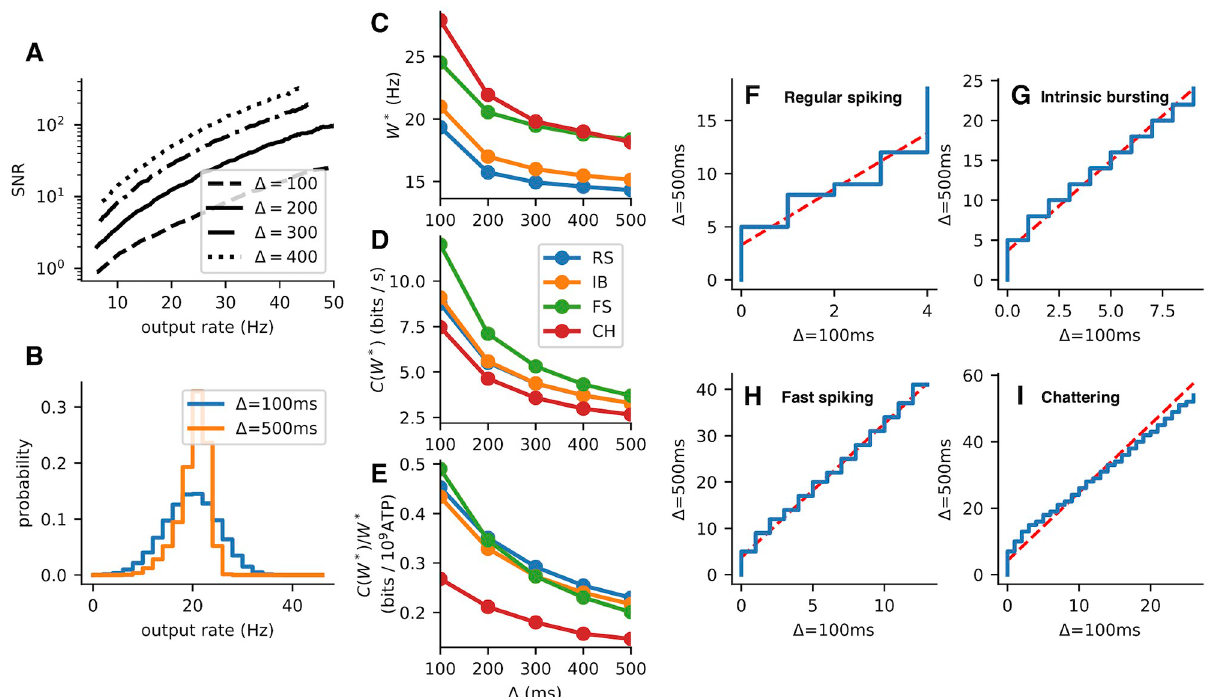
Fig 8. The effect of coding time window on metabolically efficient information transmission. (A) Signal to noise ratio for different coding time windows as a function of the mean response r ( x ) (Eq 26). (B) Comparison of response to a given stimulus (producing a response rate of approx 20 Hz) for different coding time windows. In order to get comparable results, the distribution on number of spikes in 100 was five times convoluted with itself. The distribution for 100 ms is more spread due to the adaptation effects. (C) Optimal mean PSFR (Eq 22). (D) Information capacity with the optimal metabolic expenses. (E) Metabolic efficiency in bits per spikes. The decrease with the length of the coding time window shows us, that the adaptation effects visible in B don’t play a significant role in this case. (F-I): Quantile-quantile plots comparing the PSFR distributions for different coding time windows. The red dashed line is a linear fit, acting as a visual guide. In the case of metabolically-efficient coding invariant on time scale, the q-q plots shouldn’t deviate significantly from the line. This holds for the RS and FS neurons, for the most part also for the IB neuron. For all plots in the figure the inhibition scaling factor B = 0.4 was